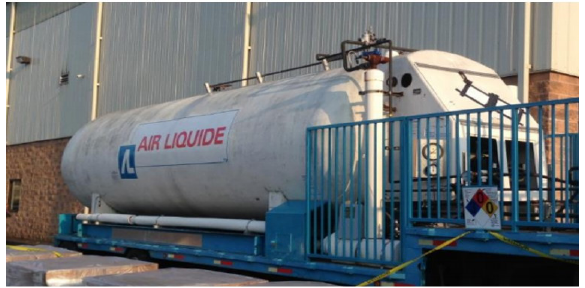
Figure 2. Tank for storing captured CO 2 . Source: [33].